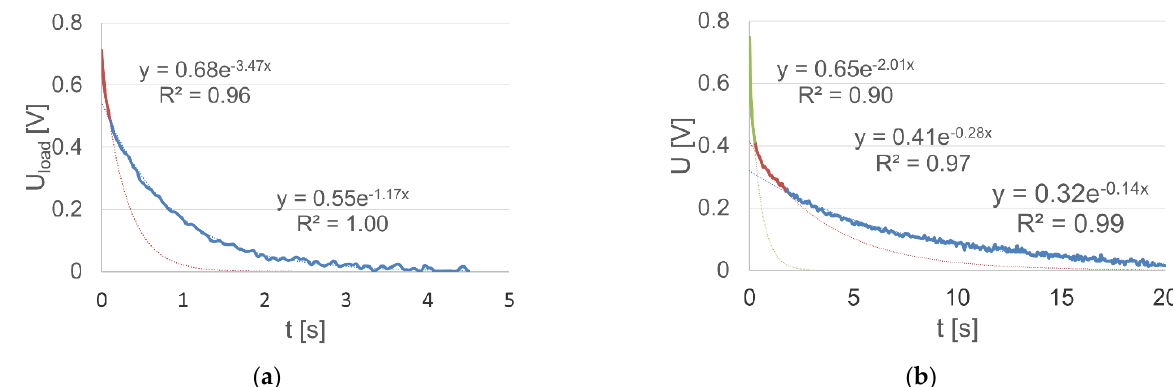
Figure 6. The variable component of the: ( a ) loaded battery voltage together with the approximating glued function lines (regression equations are written in the text (13)); ( b ) unloaded battery voltage together with the approximating glued function lines (regression equations are written in the text (14)).